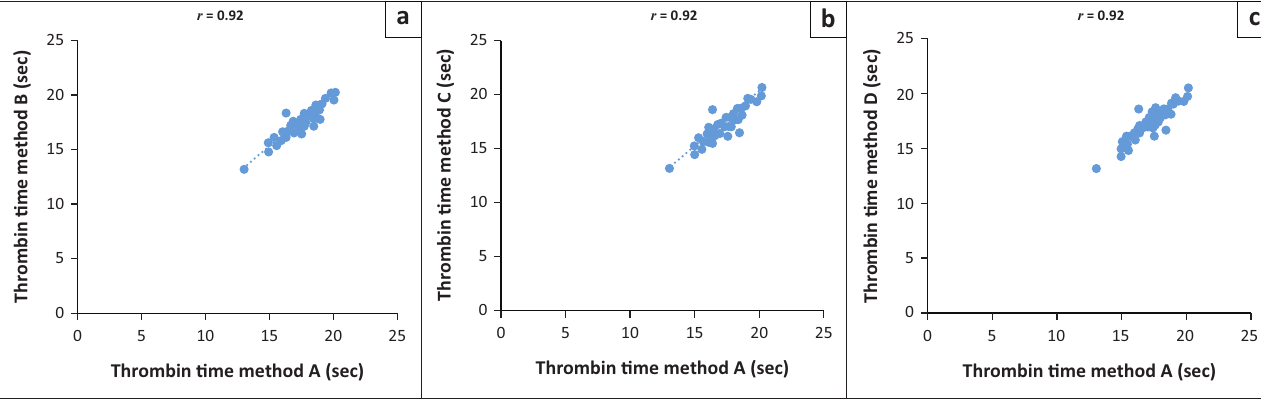
FIGURE 2: Comparison of thrombin time results between the reference centrifugation method (Method A) and Methods B, C and D, Inkosi Albert Luthuli Central Hospital and King Edward VIII Hospital, Durban, KwaZulu-Natal, South Africa, September 2021 – November 2021. Linear regressions for: (a) Method A vs Method B, (b) Method A vs Method C, (c) Method A vs Method